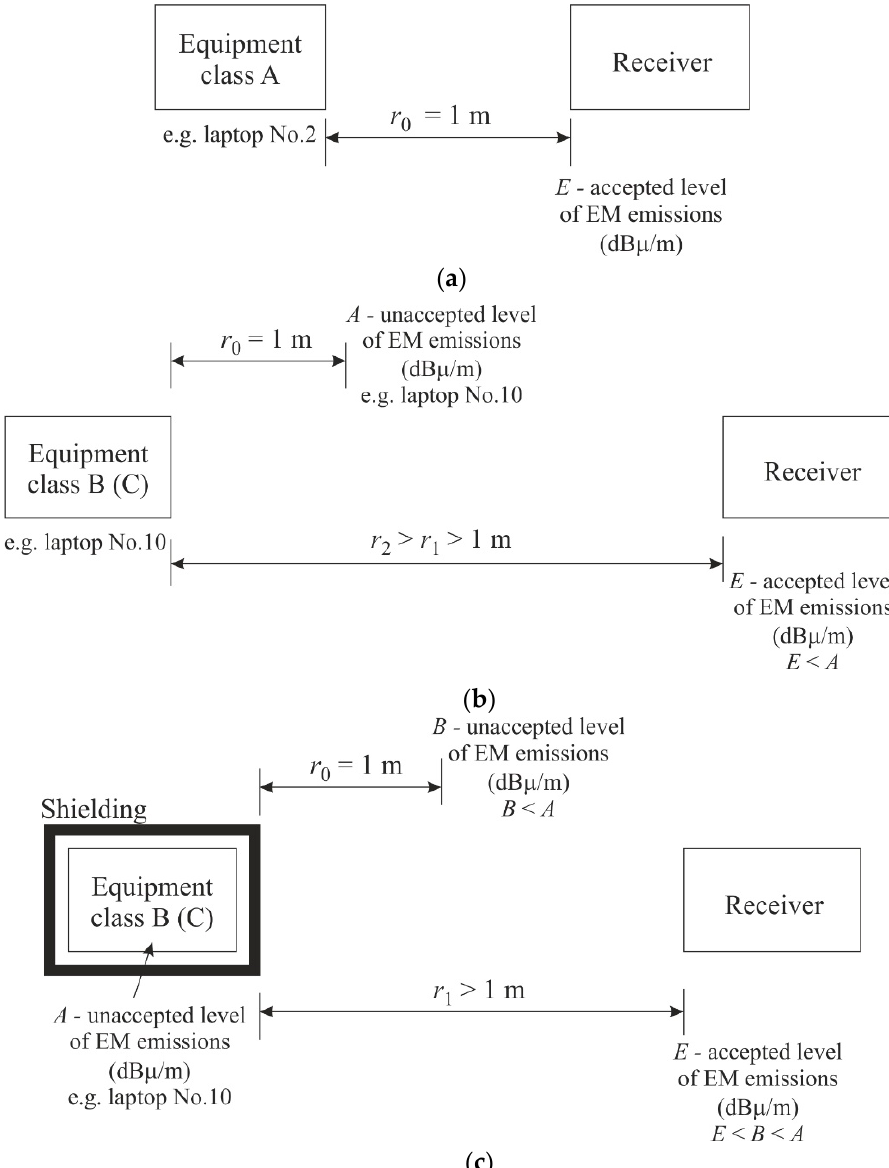
Figure 16. Attenuation methods of emission from electronic device: ( a ) equipment class A and protection zone about radius r 0 = 1 m, ( b ) equipment class B and protection zone about radius r 2 > r 1 > r 0 , ( c ) equipment class B inside of shielding and protection zone about radius r 1.